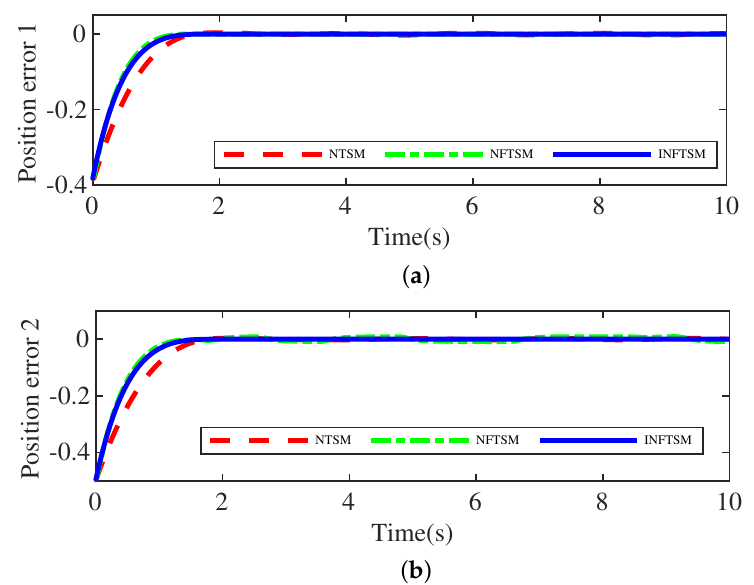
Figure 3. Comparison of position error when the system is in normal situation: ( a ) at joint 1 and ( b ) at joint